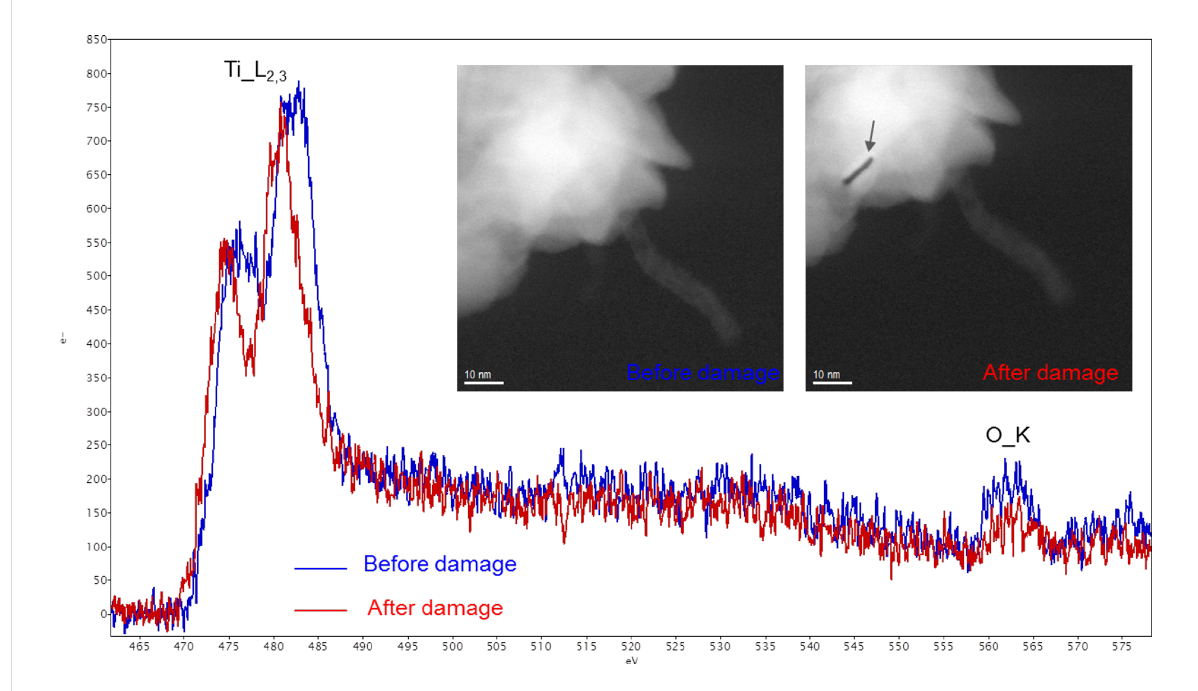
Figure 6: An example of electron beam damage during EELS acquisition. Note that there is a chemical shift in the Ti_L 2,3 edge after the damage. The damage is also visible in the STEM-HAADF